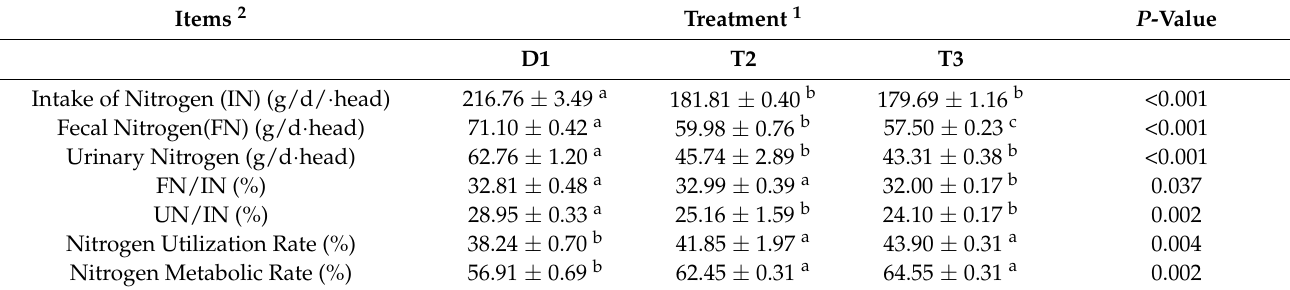
Table 4. Effects of low-protein dietary inclusion of RPLys and RPMet on nitrogen metabolism of Holstein